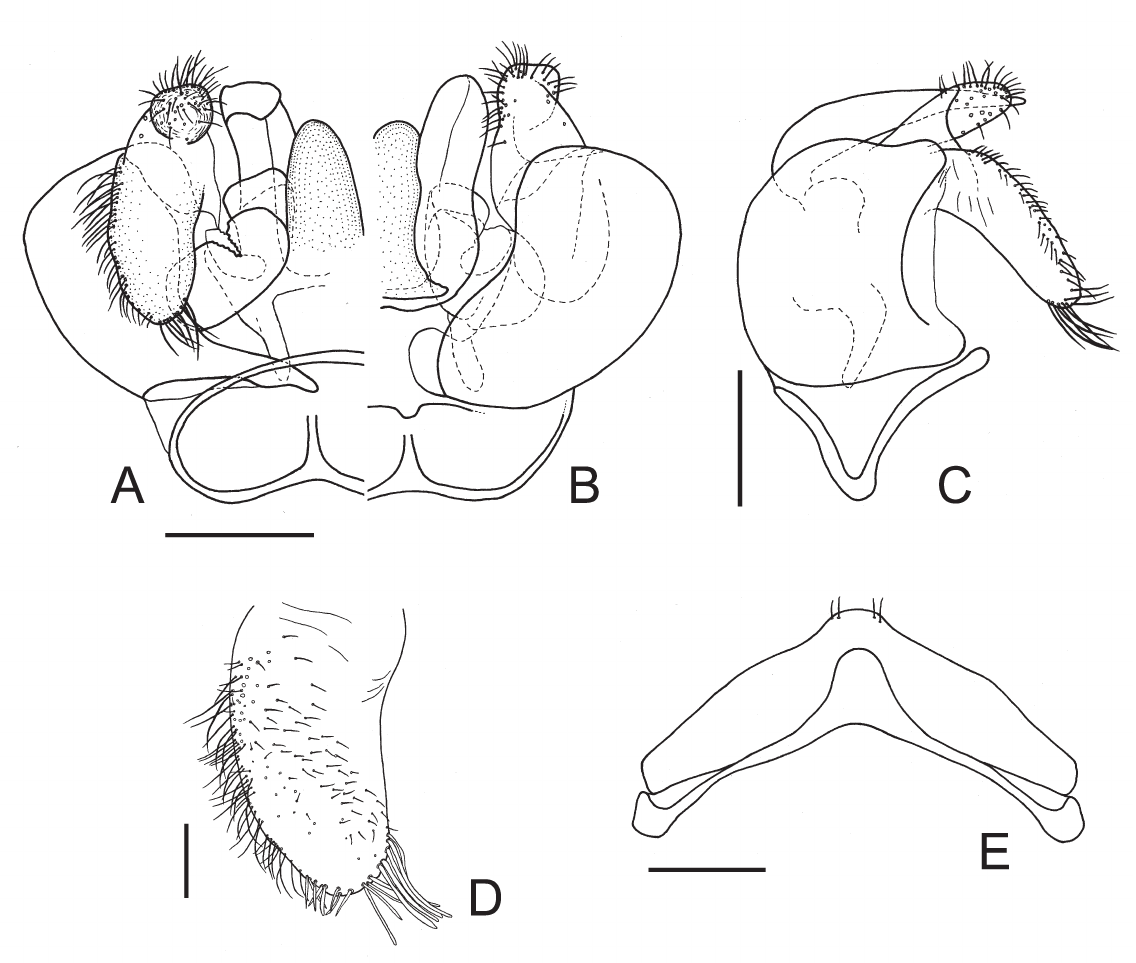
Fig. 21. Lasioglossum ( Dialictus ) ellipticeps (Blüthgen, 1923), ♂. A . Genitalia in ventral view. B . Geni- talia in dorsal view. C . Genitalia in lateral view. D . Ventral retrorse lobe of genitalia. E . S7–S8. Scale bars: a–c, e = 0.2 mm, d =